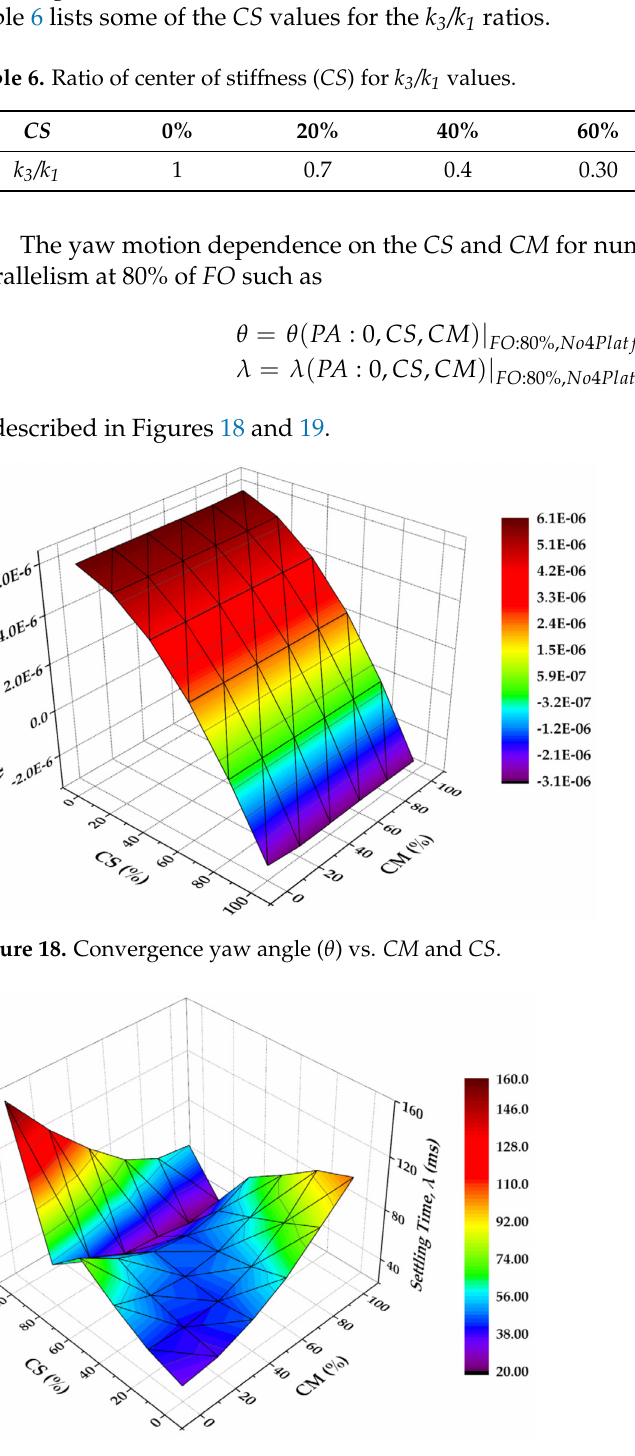
Figure 19. Settling time ( λ ) vs. CM and CS